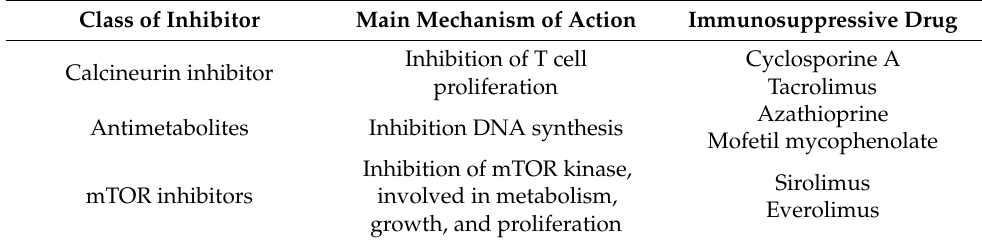
Table 1. Class of inhibitors and main working